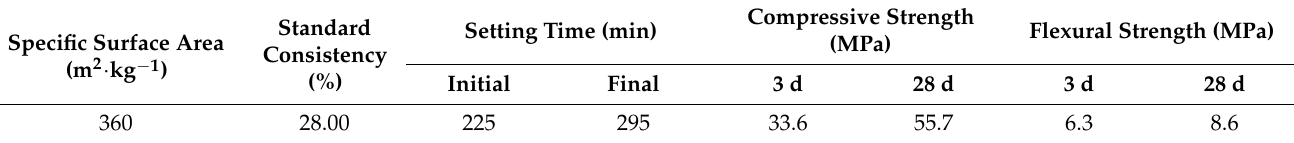
Table 3. Performance index of cement.